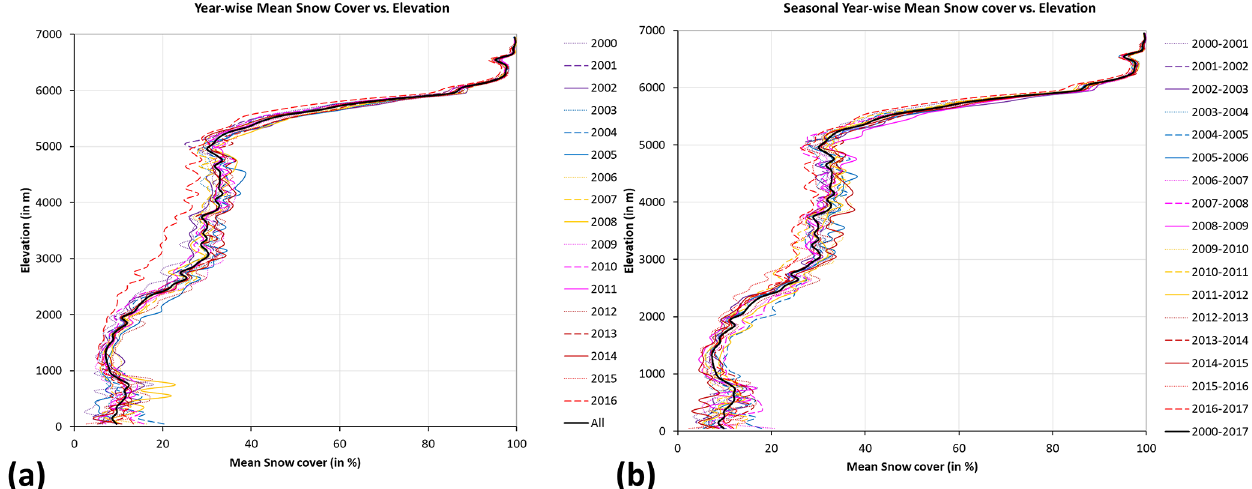
Figure 3. The hypsographic curves of the (a) year-wise mean snow cover (in percent) for 2000–2016 and (b) seasonal year-wise (March to February) snow cover (in percent) for 2000–2017, respectively, over the HKH region. Note that the seasonal average of snow cover for year 2016 is lower because of missing data for the months of January and